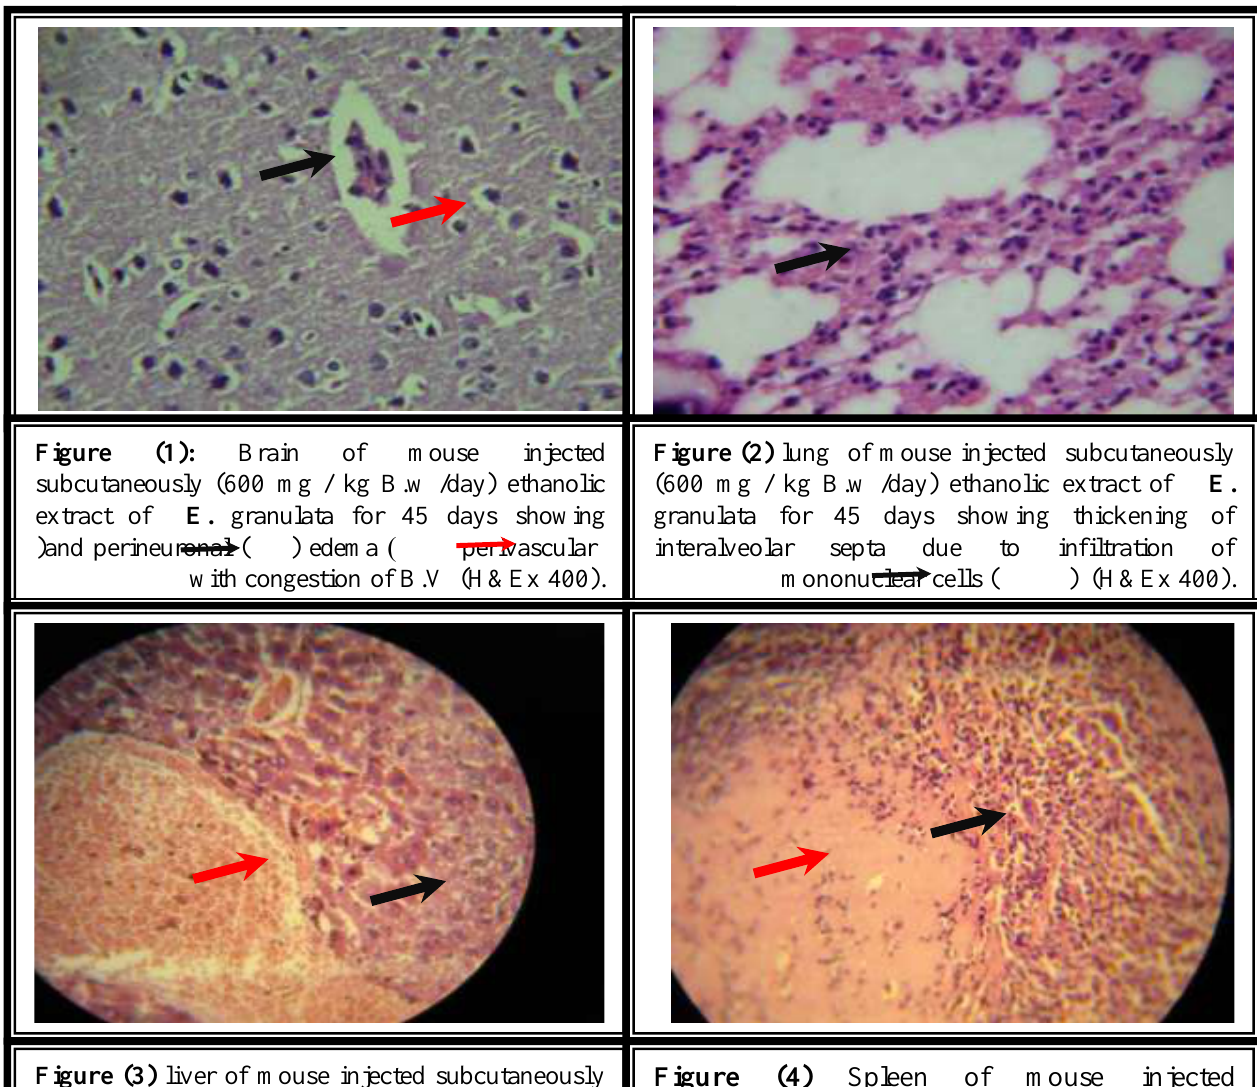
(4) Spleen of mouse injected subcutaneously (600 mg / kg B.w /day) ethanolic extract of E. granulata for 45 days showing deposition of amyloid substance